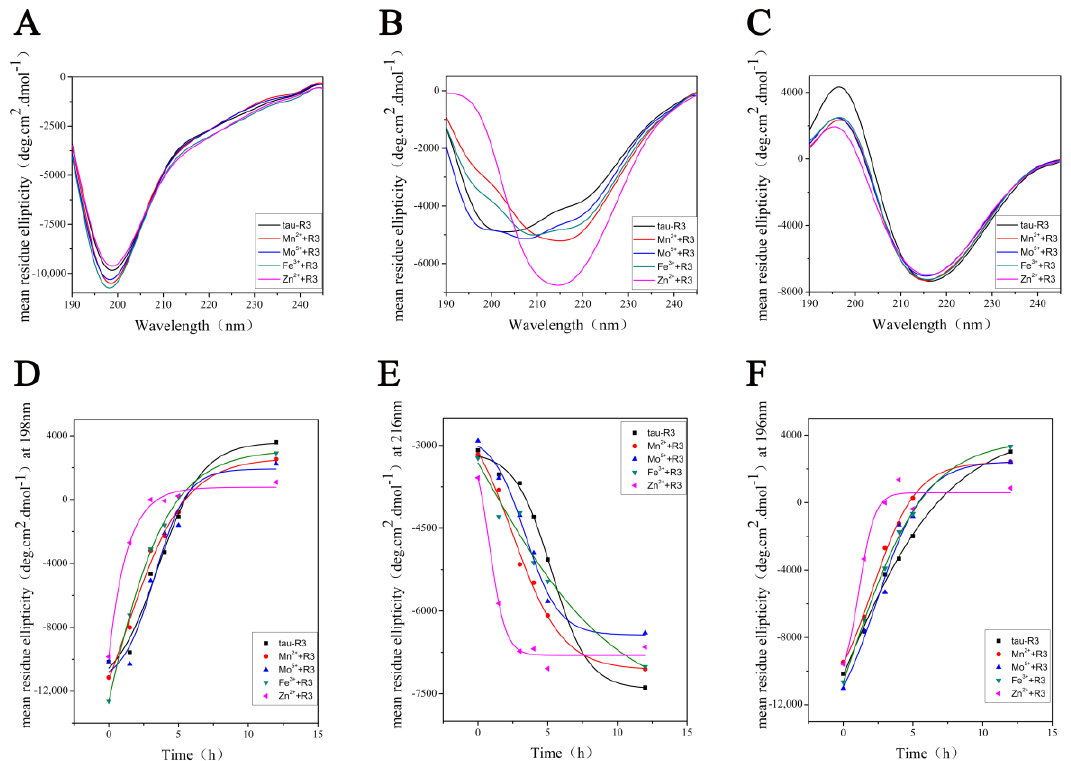
Figure 4. Metal cations altered the secondary structure of tau-R3. ( A – C ) Circular dichroism spectra of tau-R3 binding with different additives (Mn 2+ , Mo 5+ , Fe 3+ , and Zn 2+ ) incubated at 37 ◦ C for zero, three, and 24 h, respectively. ( D – F ) mean residue ellipticity (deg.cm 2 .dmol − 1 ) of tau-R3 incubated with different additives (Mn 2+ , Mo 5+ , Fe 3+ , and Zn 2+ ) at 198 nm, 261 nm, and 196 nm, respectively in Phosphate buffer (PB) buffer (1.44 g/L Na 2 HPO 4 , 0.24 g/L KH 2 PO 4 , pH =